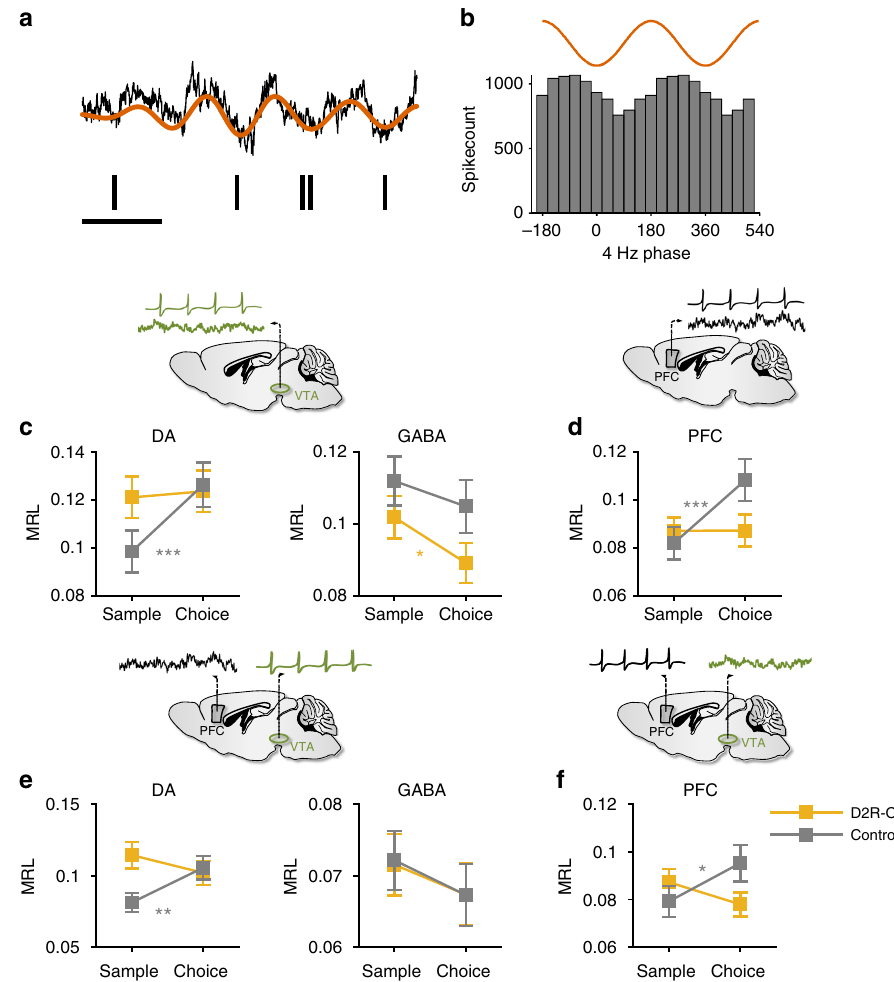
Fig. 4 The recruitment of VTA DA and PFC neurons by 4 Hz oscillations during WM is disrupted in D2R-OE mice. a Example spike train of a VTA neuron (black lines) and the simultaneously recorded VTA LFP (top). The raw trace is shown in black and the same trace fi ltered between 3 and 6 Hz is shown in red. Scale bar: 250 ms. b Histogram of the phases of the 4 Hz oscillation at which the neuron in ( a ) spiked, indicating phase-locking to the trough of the 4 Hz oscillation. c , d Phase-locking of VTA DA ( c , left, Control: n = 75; D2R-OE: n = 68), VTA GABA ( c , right, Control: n = 141; D2R-OE: n = 132) and PFC ( d , Control: n = 74; D2R-OE: n = 98) neurons to local 4 Hz oscillations in sample and choice phases. MRL: Mean resultant length (see Methods). Phase- locking of VTA DA and PFC neurons from control animals was stronger in the choice phase (*** p < .001, sign-rank test) but not the phase-locking of VTA GABA neurons ( p = 0.13). In D2R-OE mice an increase in phase-locking was not observed in VTA DA ( p = 0.83) or PFC ( p = 0.67) neurons whereas phase-locking was lower in VTA GABA neurons during the choice phase (* p < .05, sign-rank test). e , f Long-range phase-locking of VTA DA ( e , left) and GABA ( e , right) neurons to PFC 4 Hz oscillations and PFC neurons ( f ) to VTA 4 Hz oscillations. Long-range phase-locking was stronger in the choice phase in VTA DA and PFC neurons of control animals (** p < .01; * p < .05, sign-rank test) but not in VTA GABA neurons ( p = 0.13). In D2R-OE mice an increase in long-range phase-locking was not observed (VTA DA: p = 0.14, VTA GABA: p = 0.36, PFC: p = 0.12). Error bars represent mean ± s.e.m measured across neurons. Brain diagrams in c – f are adapted with permission from ref. 62 ,